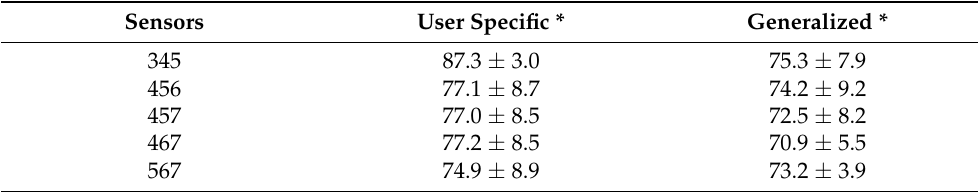
Table 8. Classification results for different sensor combinations when assessing model performance using varying AP™ and transmitter sensor placements after training the model based on the data of sensors 3, 4, and 5. Shown are mean accuracies (%) and the corresponding standard deviation of all seven subjects when developing user-specific or generalized